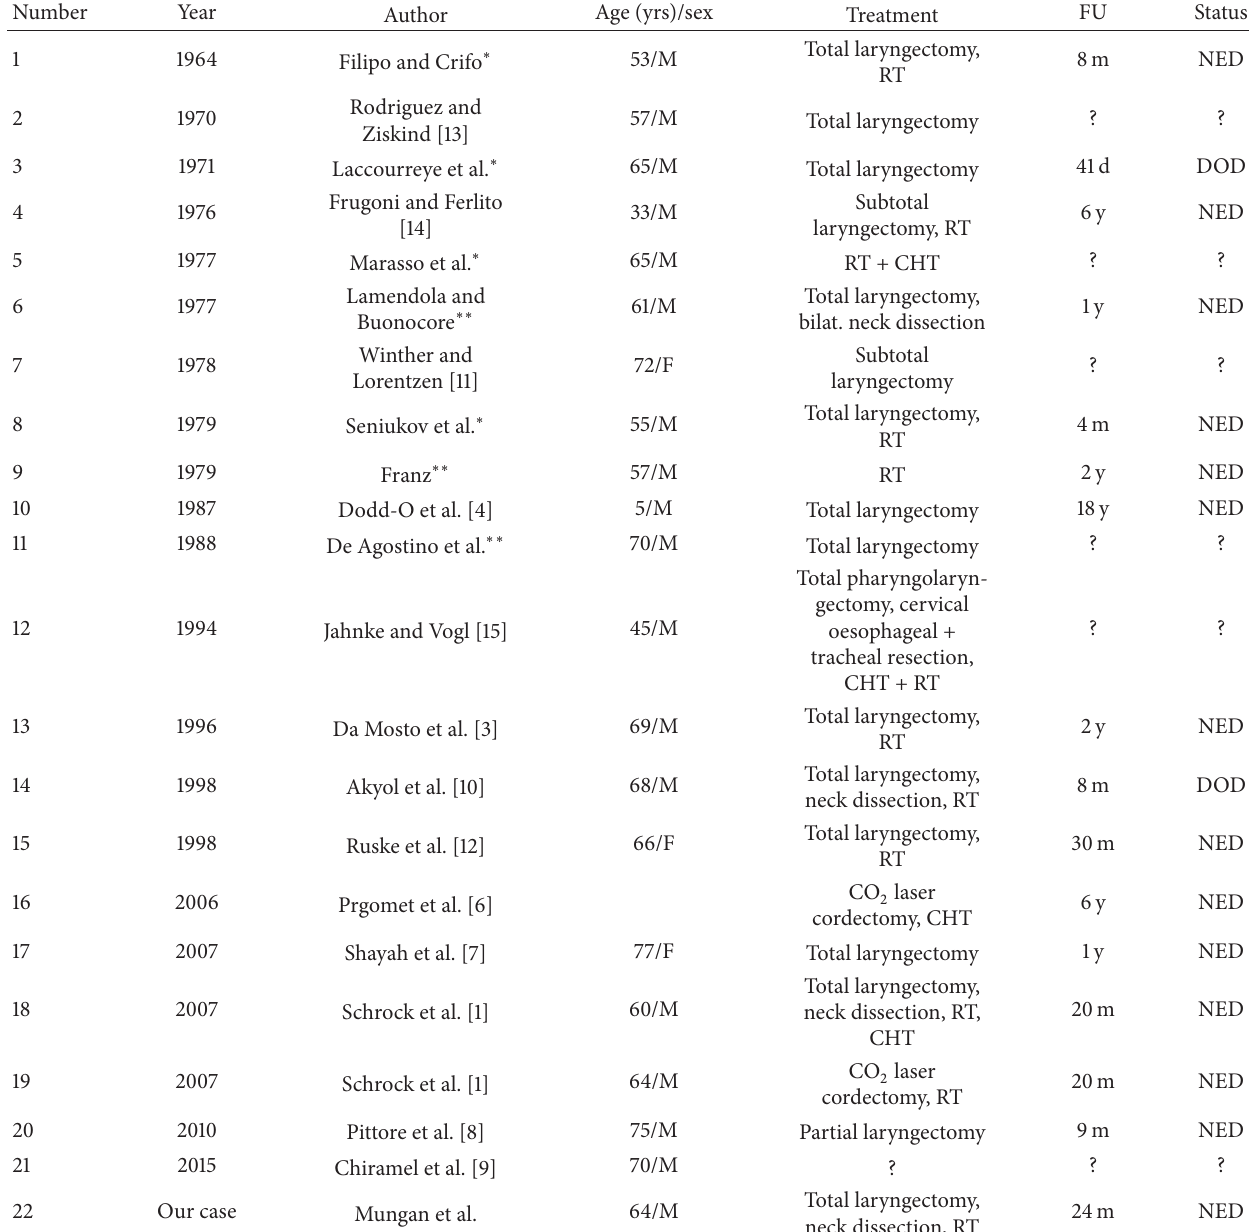
Table 1: Case reports of laryngeal pleomorphic